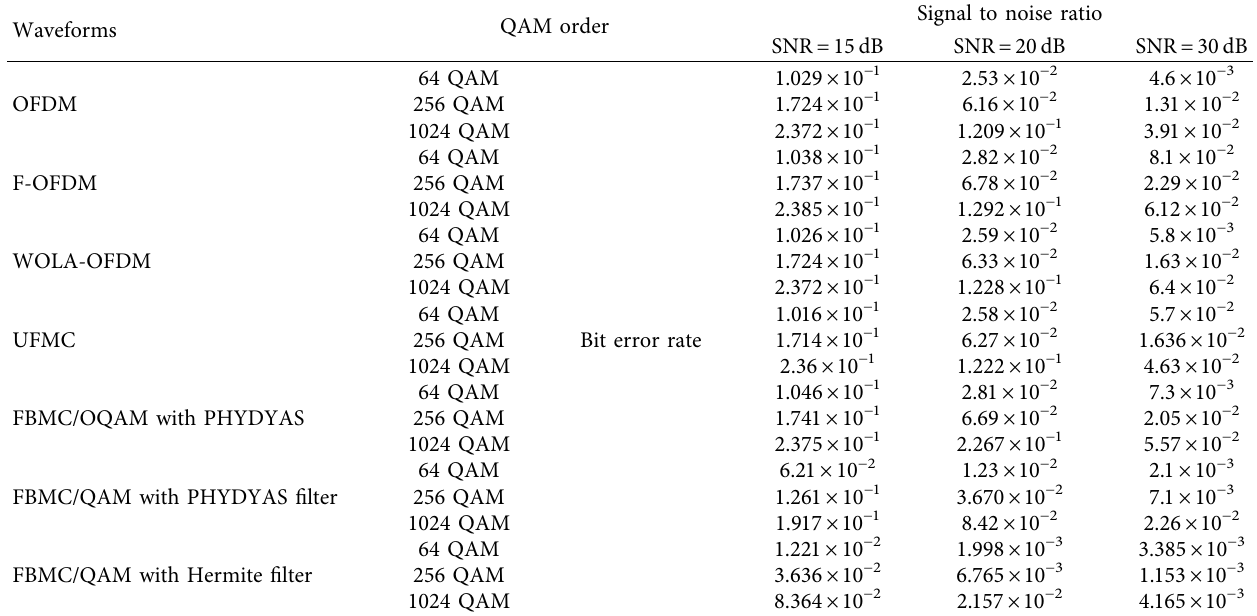
Table 5: Bit error rate performance of multicarrier modulation techniques with 64 QAM, 256 QAM, and 1024 QAM for Pedestrian B channel